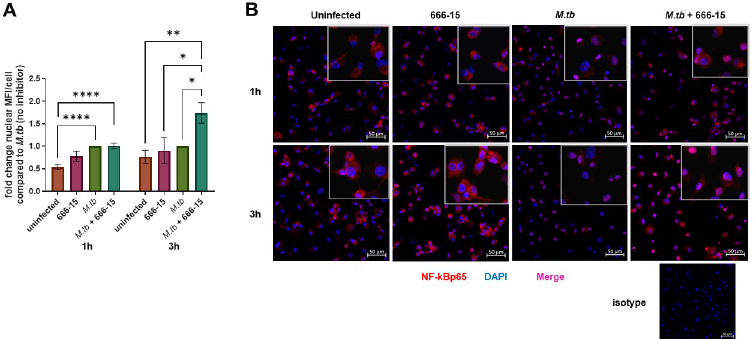
Fig 4. Inhibition of M . tb -induced CREB activation allows for prolonged nuclear colocalization of NF-kB p65 in human macrophages. MDMs were pretreated with DMSO or the CREB inhibitor, 666–15, for 60 min then infected with M . tb H 37 R v at MOI 10. A) At 1h and 3h post-infection, cells were fixed, permeabilized, and stained for NF-kB p65 (red) and DAPI in the nucleus (blue). MFI of NF-kB p65 signal that colocalized with DAPI (magenta) was calculated using ImageJ software, normalized to total number of cells per field and graphed as fold change ± SEM compared to infected cells. Data are cumulative of n = 3–6 donors. One-way ANOVA with Tukey’s post-test. B) Images were taken at 3h post-infection at 20x magnification. Images shown are representative of n = 3–6 donors; * p < 0.05, ** p < 0.01, **** p <